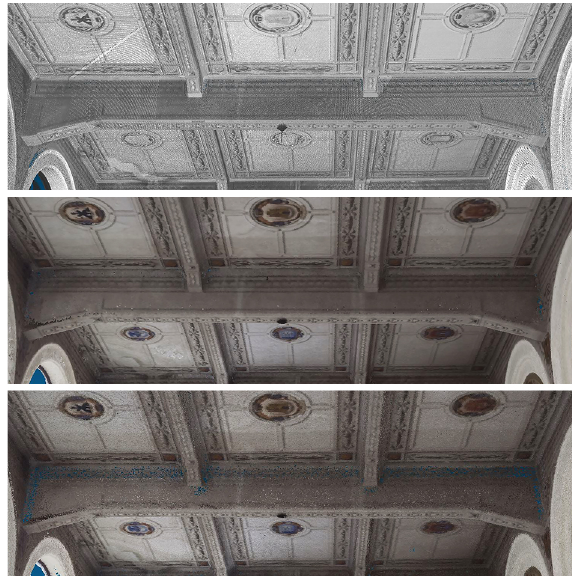
Figure 7 . Details of the joists of the point cloud (from top to bottom) of the laser scanner, the photogrammetric point cloud processed with Agisoft Metashape and that with eyesCloud3d.